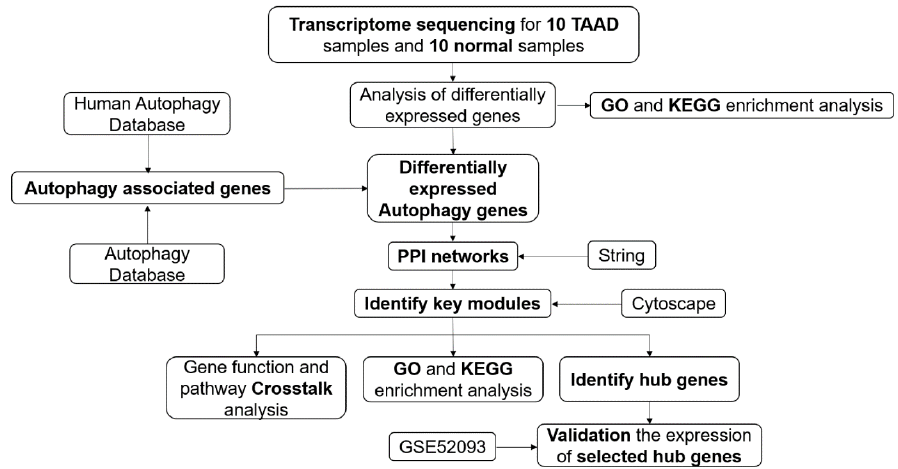
Figure 1. Overall protocol of the study. TAAD, type A aortic dissection; PPI, protein–protein interaction. Table 1. Clinical information of TAADs and normal samples.